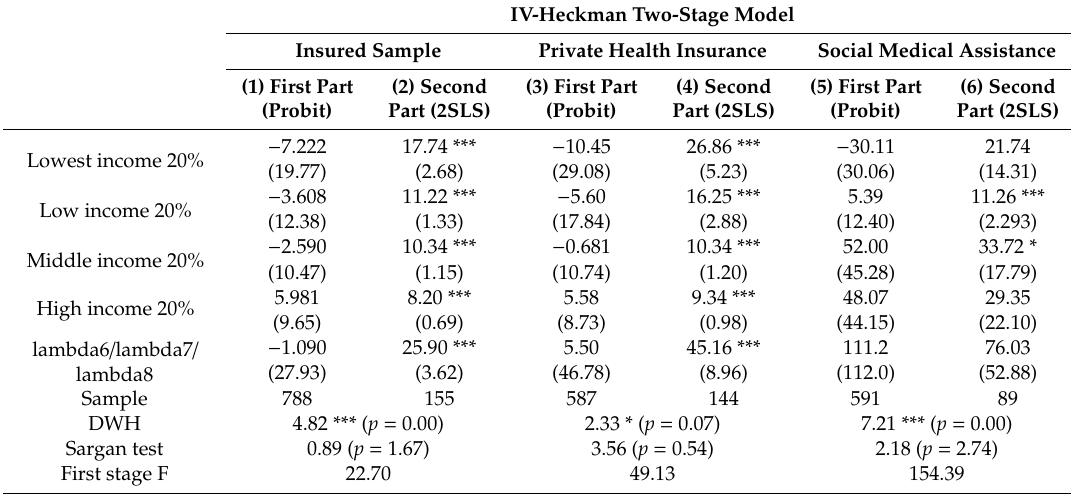
Table 6. Medical care compensation levels with di ff erent incomes and estimation of introducing restrictive variables.